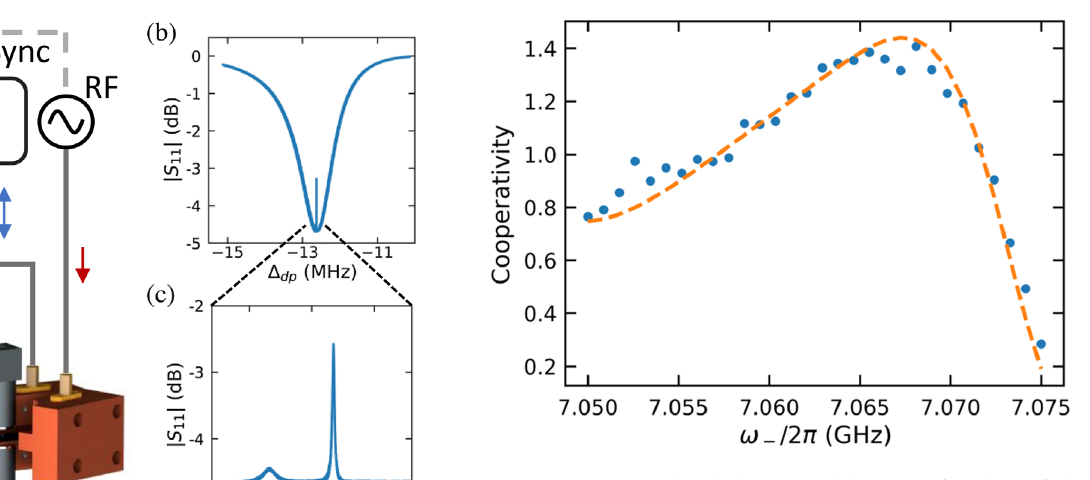
FIG. 8. Magnomechanical cooperativity as a function of the lower normal mode frequency. For each measurement the drive tone is detuned by the phonon frequency from the lower normal ω − Ω mode, ω . Blue circles are experimentally deter- − d ¼ b parameter.FIG. 7. Magnomechanically induced transparency. (a) Sche- mined using Eq. (B1), and the dotted orange line is a numerical matic illustration of the measurement setup: VNA, vector net- fit using Eq. (B2), where g 0 is the only fit mb work analyzer; RF, microwave generator. The VNA and source are synced using a 10 MHz clock signal. Included is a rendering of the microwave cavity and magnetic yoke assembly. The frequency axis is negative due to the relative detuning between the drive tone and the normal mode. (b) Normalized reflection spectrum centered around the lower-normal mode, the system is tuned near spectrum (c) from Fig. 2, but at a larger solenoid current to isolate the magnonlike normal mode. A narrow − Ω transparency window opens as Δ due to the magno- dp ¼ b mechanical coupling. (c) Enlargement of (b) showing a detailed spectrum of the magnomechanical-induced